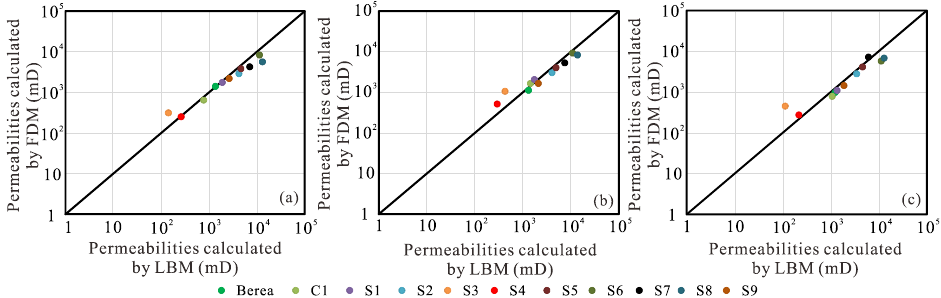
Figure 21. Comparison between the permeabilities calculated by LBM [50] and IFDM for digital rock images after grid coarsening two times. ( a ) Permeabilities calculated in macroscopic flow direction of x ; ( b ) Permeabilities calculated in macroscopic flow direction of y ; ( c ) Permeabilities calculated in macroscopic flow direction of z . Table 1. Porosity and resolution of the digital rock images and original digital rock image size used for flow simulation.